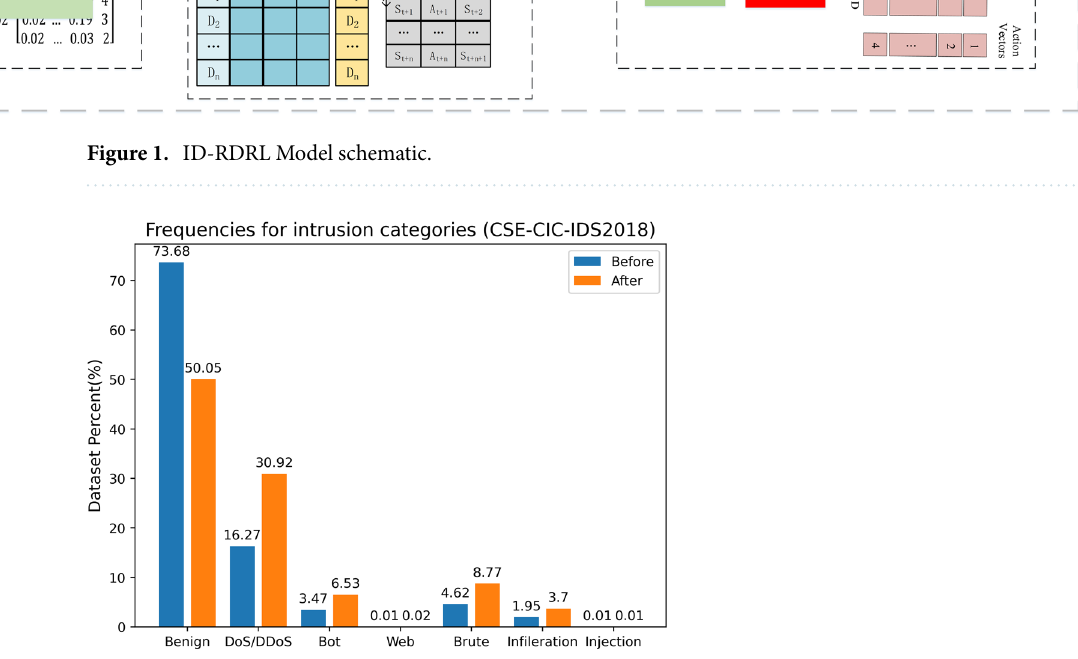
Figure 2. Frequencies for intrusion